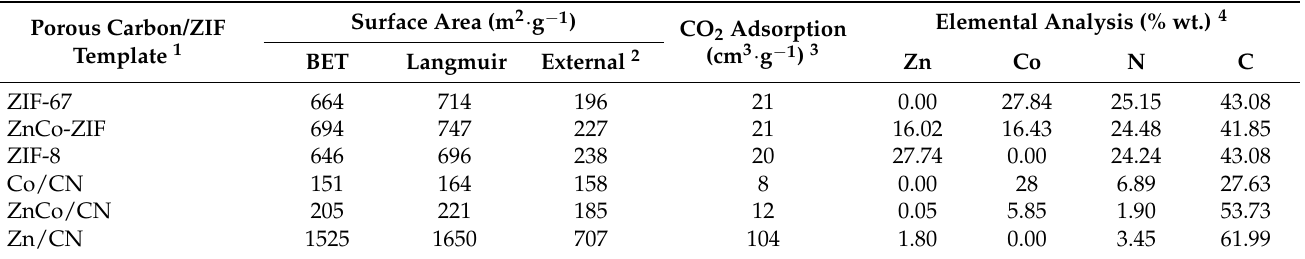
Table 1. The porosity properties, CO 2 adsorption and C, N element analysis of porous carbon materials deriving from ZIF templates.